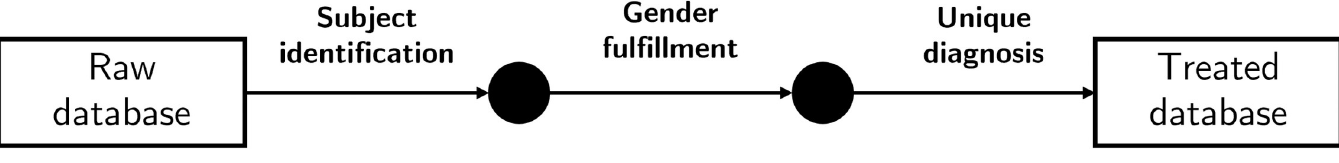
Fig 1. SerumCovid initial